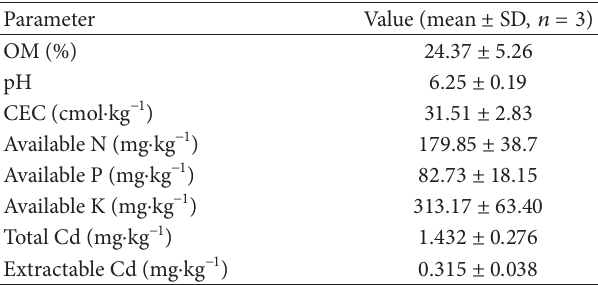
Table 1: Selected physical and chemical characteristics of soil in the